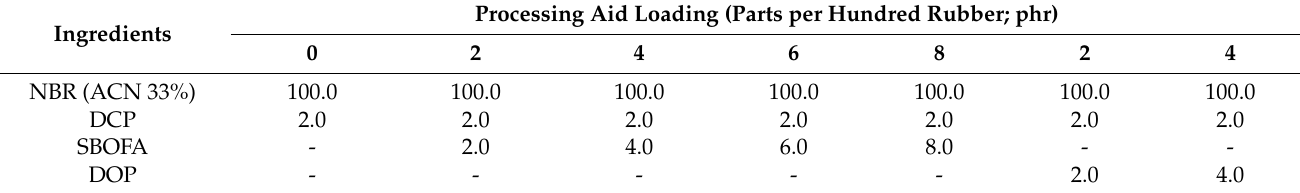
Table 2. Formulations of rubber